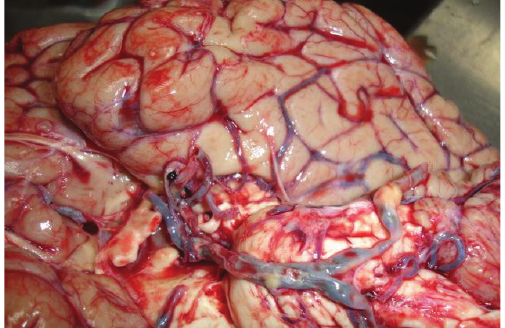
Figure 1: Macroscopy of the brain; the occluded thrombotic basilar artery is seen.